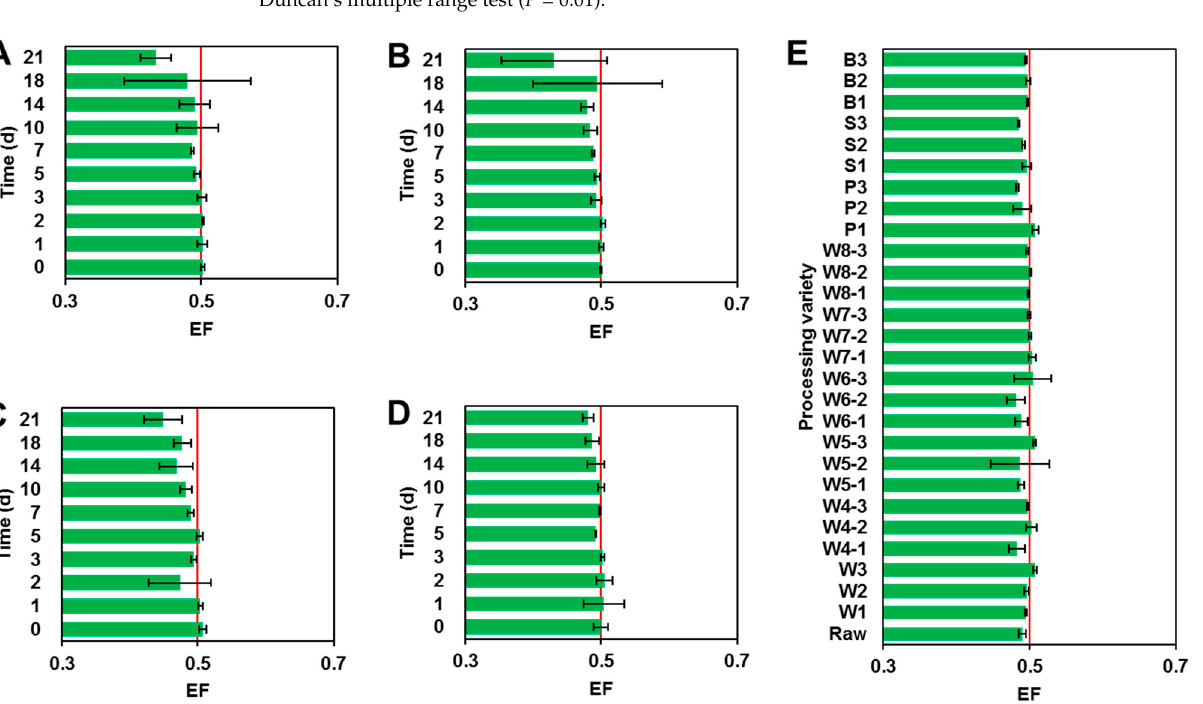
Figure 1. EF values of penthiopyrad in eggplant samples under field conditions. ( A – E ) represent spraying dose of 75 g a.i./ha two and three times, spraying dose of 99 g a.i./ha two and three times and processing, respectively.